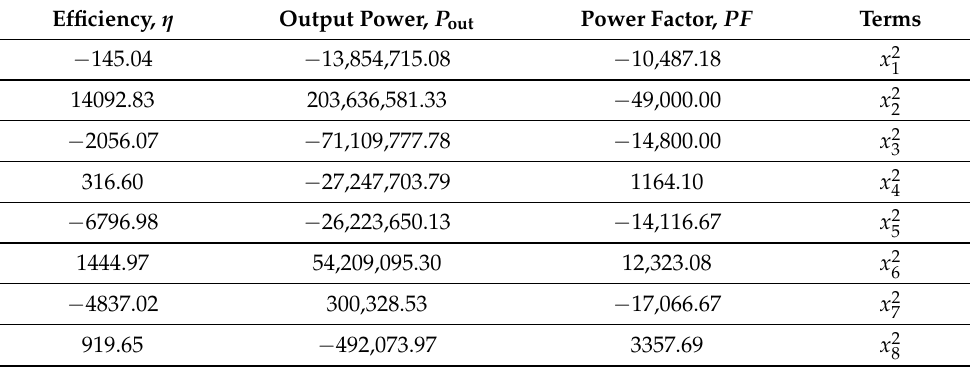
Table A2. Quadratic closed form equation of Box–Behnken design—second-order squared terms.